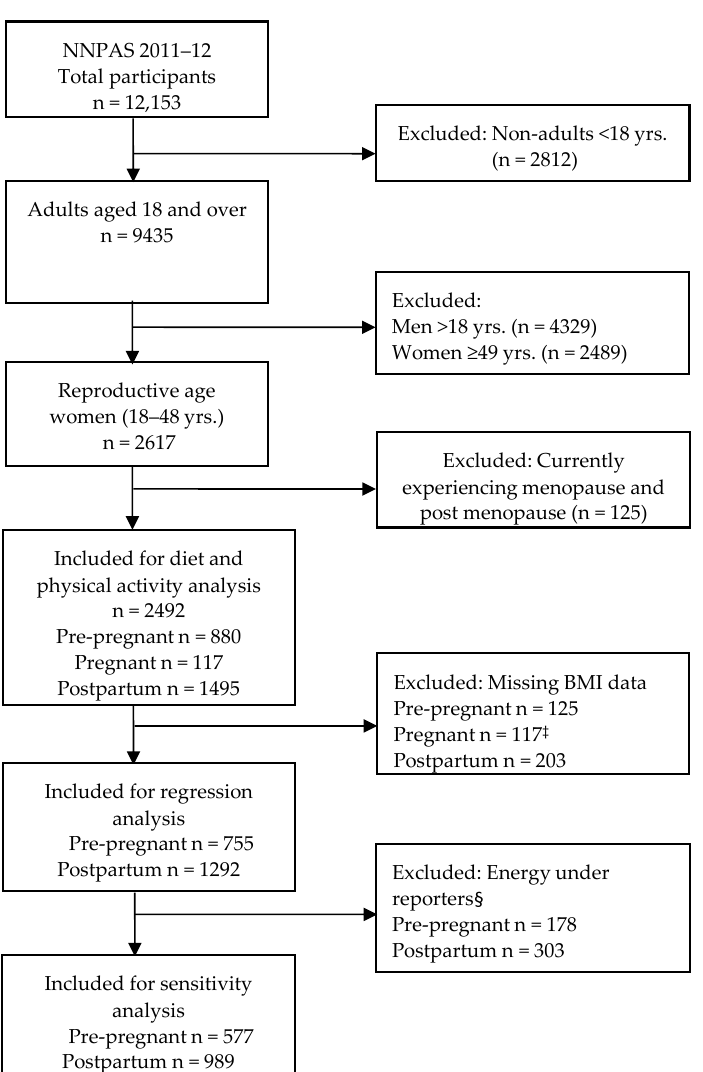
Figure 1. Flow diagram of study participant inclusion for analysis. NNPA, National Nutrition and Physical activity Survey. ‡ Weight/BMI measurement from pregnant women was not taken. § Energy under reporters based on Goldberg cut-off (EI:BMR <